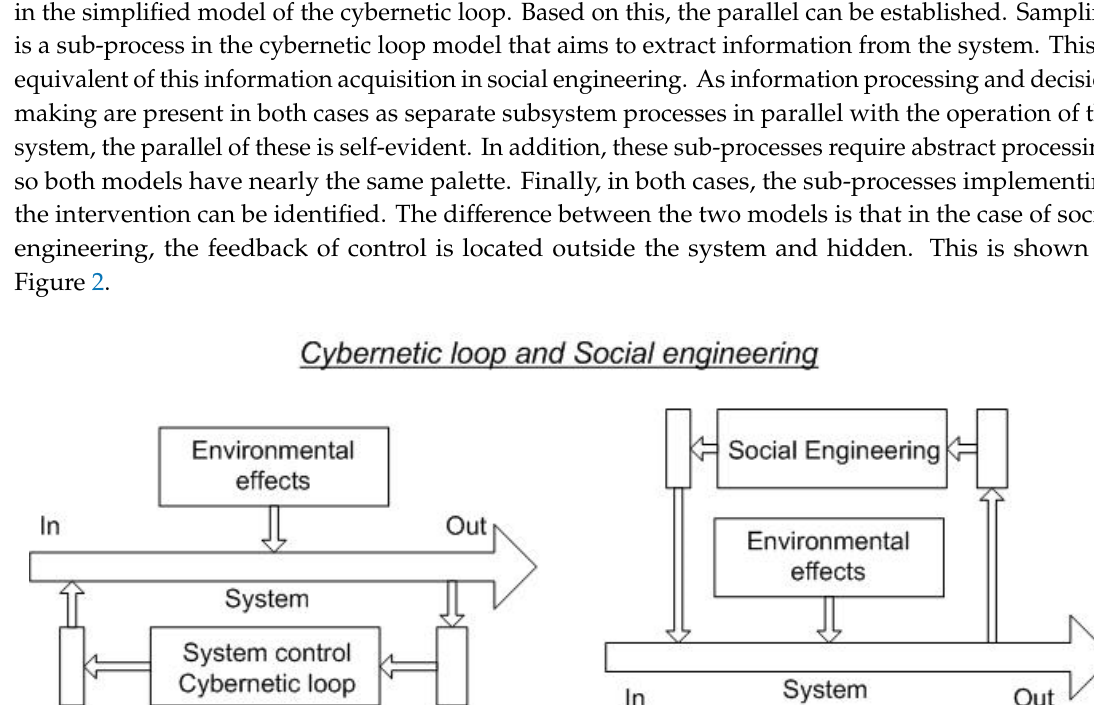
Figure 3. Unified model of cybernetic loop and social engineering.